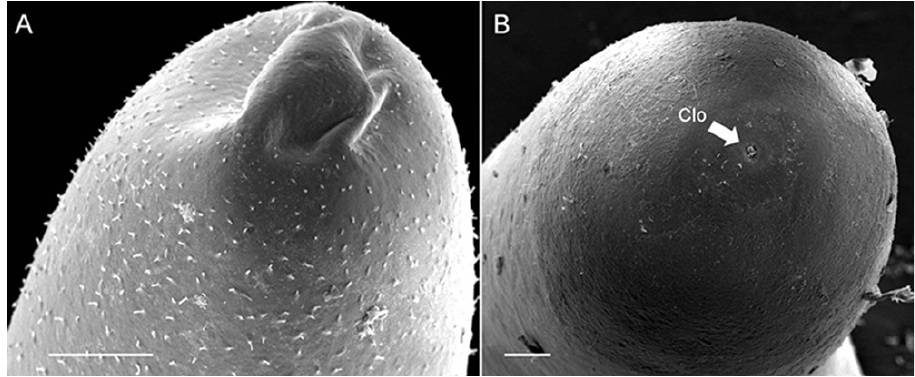
Figure 4. Female Acutogordius taiwanensis sp. n. A Anterior end B Posterior end. Clo, cloacal opening. Scale bars 100 µm ( A–B